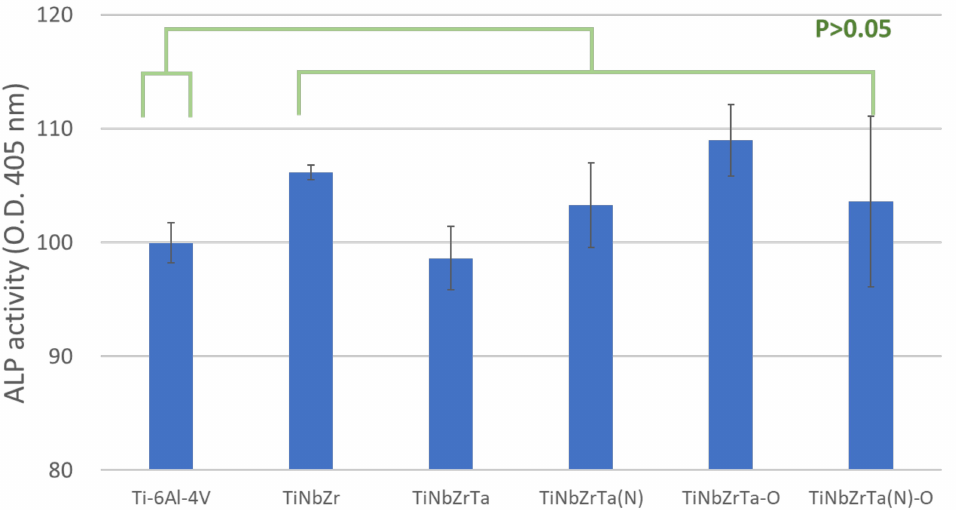
Figure 8. ALP analysis of MG-63 cultured on uncoated Ti-6Al-4V and TiNbZrTa series films for five days. No significant difference was noted among these groups ( p >